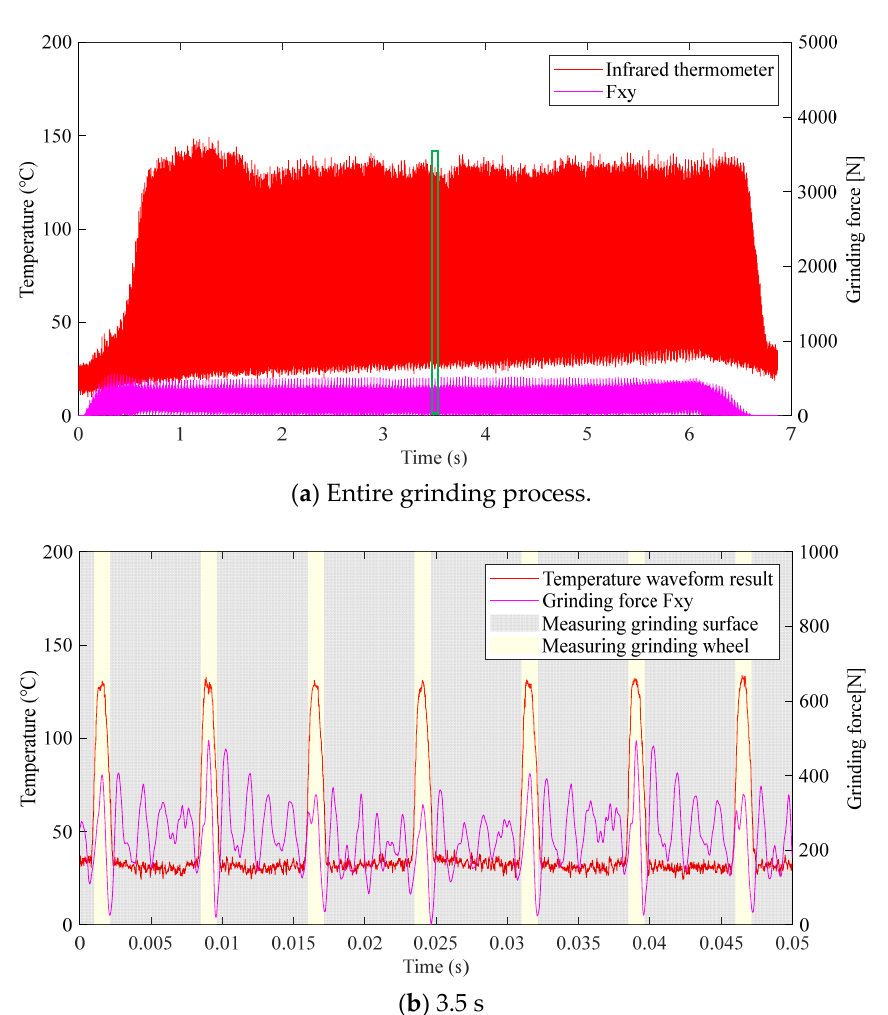
Figure 19. Transition of temperature and grinding force (1 path).